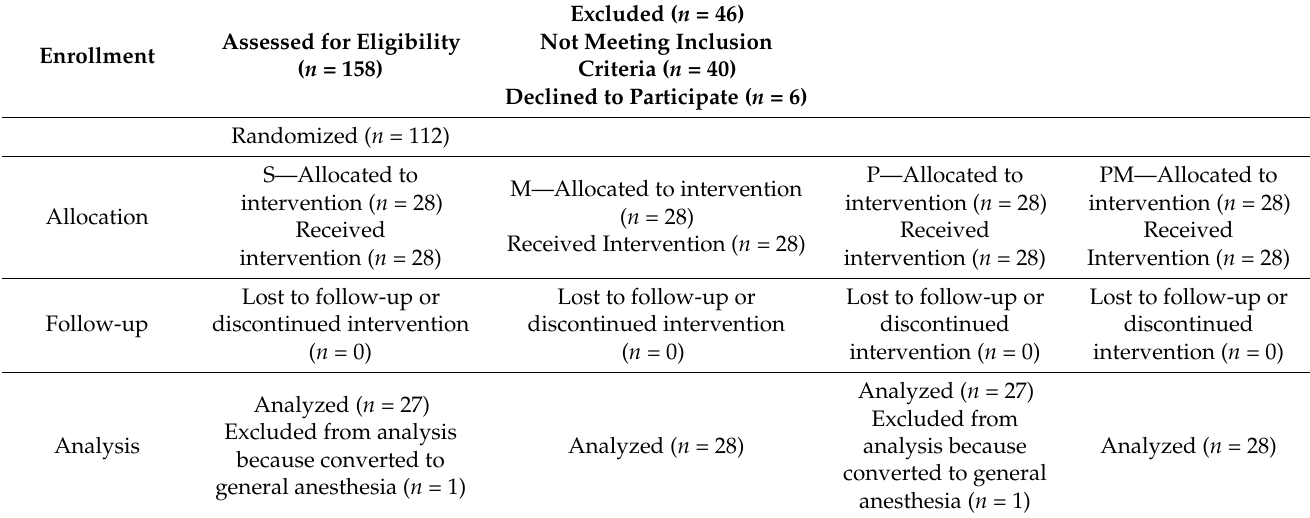
Table 1. CONSORT flow diagram.